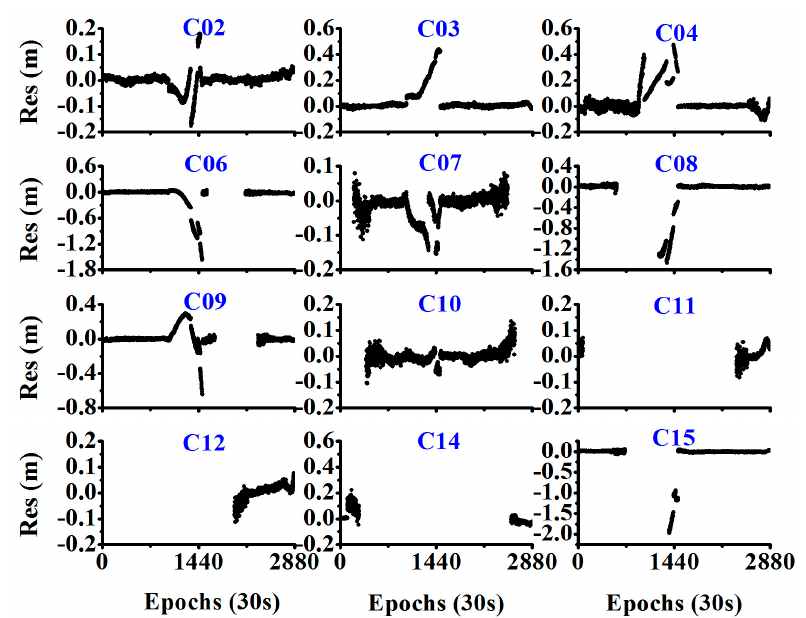
Figure 4. Observation residuals of different PRN satellites (Satellite C04 showed orbital maneuver